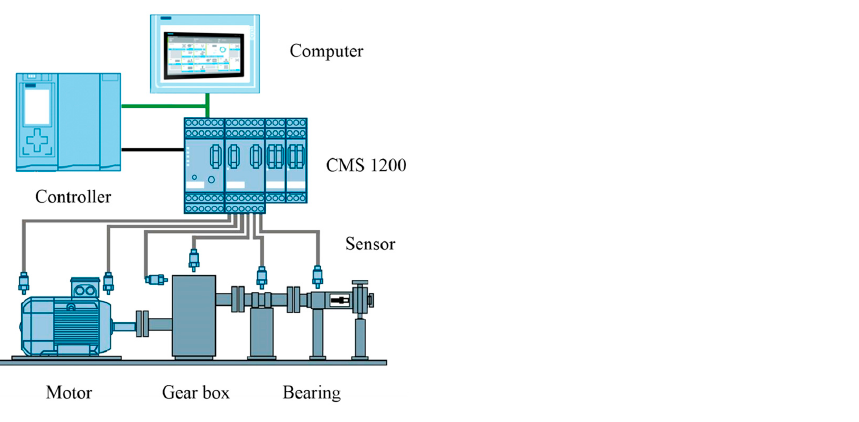
Figure 11. Schematic sketch of the experimental test platform structure.